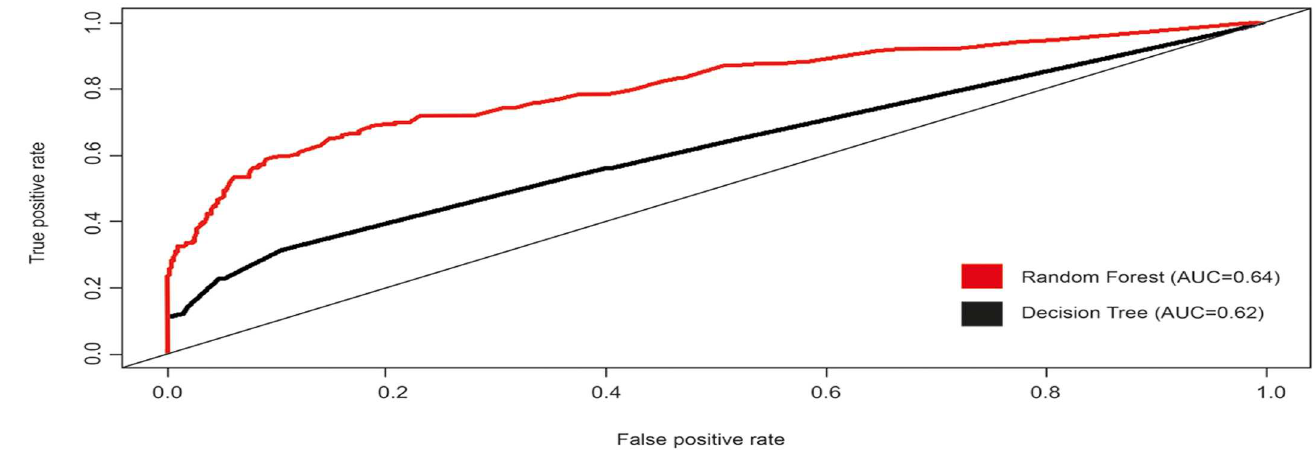
Fig 1. ROC curve for Decision tree and Radom forest.